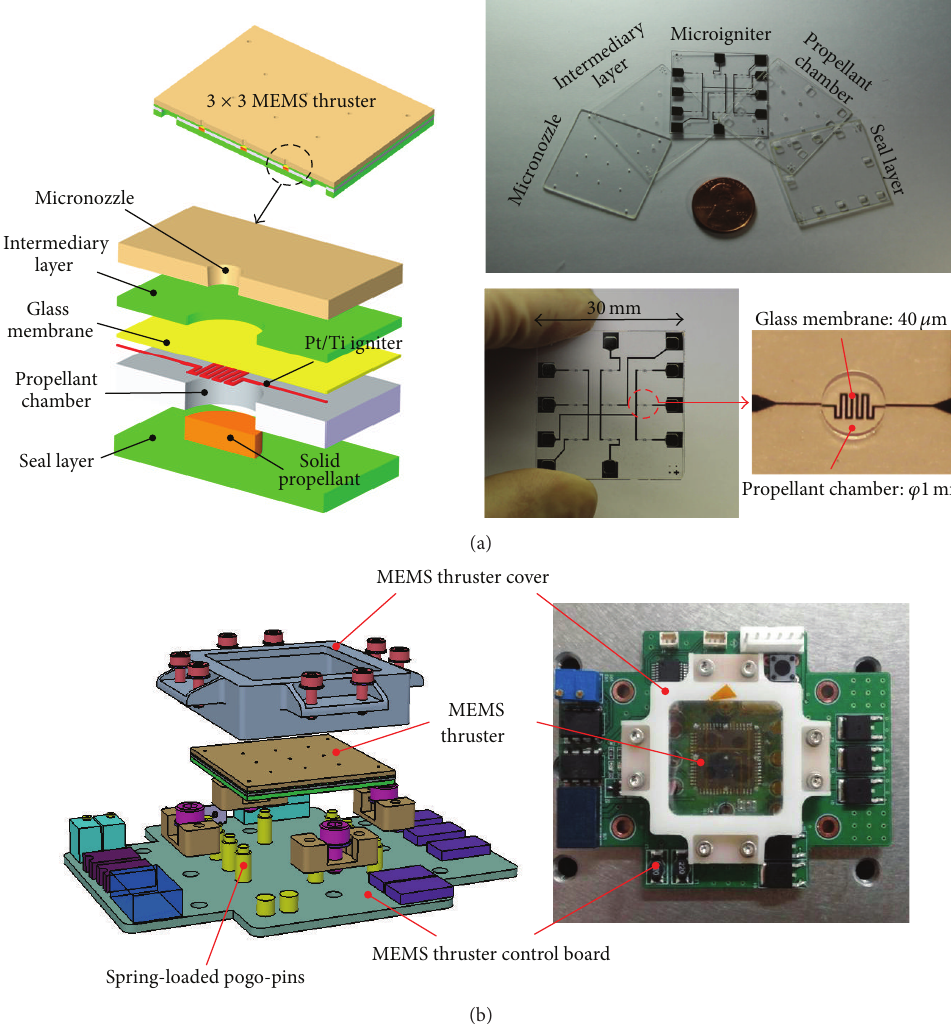
Figure 6: MEMS-based solid propellant